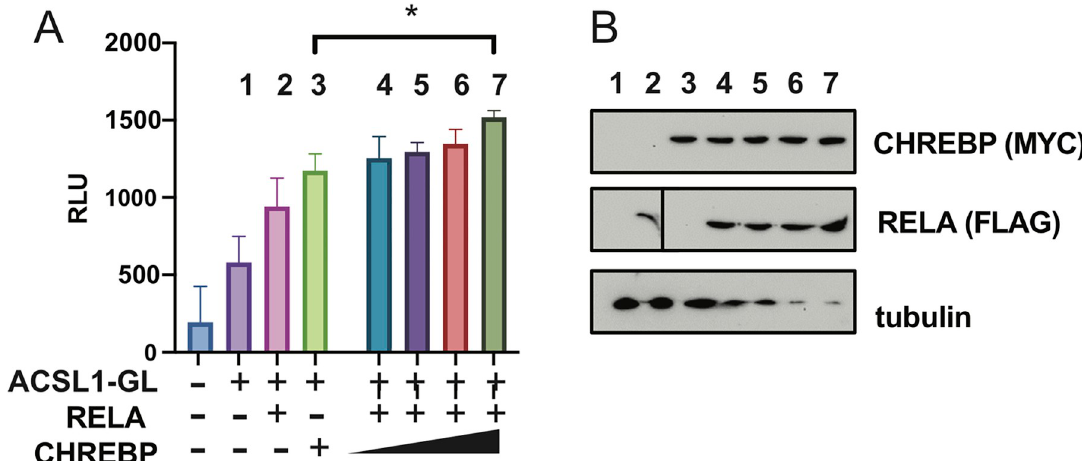
Fig 5. CHREBP and NF-kappa B increase Acsl1 transcriptional activity. HEK293 cells cultured in HG conditions were transfected with Acsl1 -GLuc reporter (250ng; columns 1–7) and individually with p65/RELA (150ng; column 2) or CHREBP (150ng; column